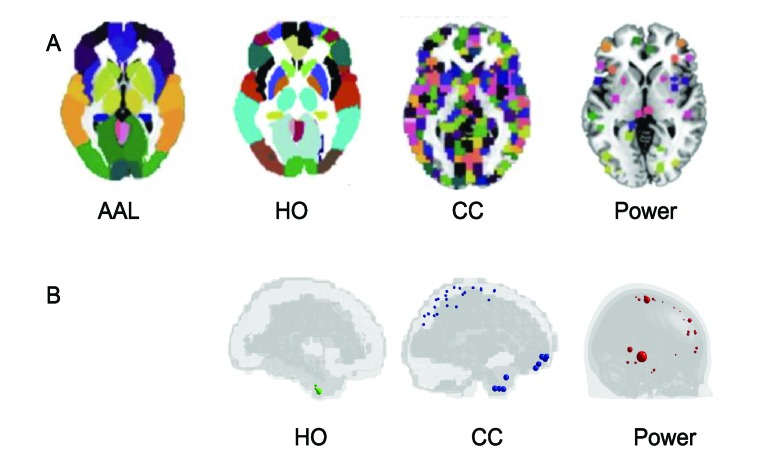
Parcellation schemes used in this analysis (A): Automated Anatomical Labeling (AAL), Harvard-Oxford (HO), Craddock (CC) and Power atlases used in functional connectivity analysis. Regions with null time series obtained in implementing the HO, CC, and Power atlases on data (B). Critical regions are represented as spheres positioned in the centroid of each atlas region, with a radius proportional to the number of subjects presenting that critical region.